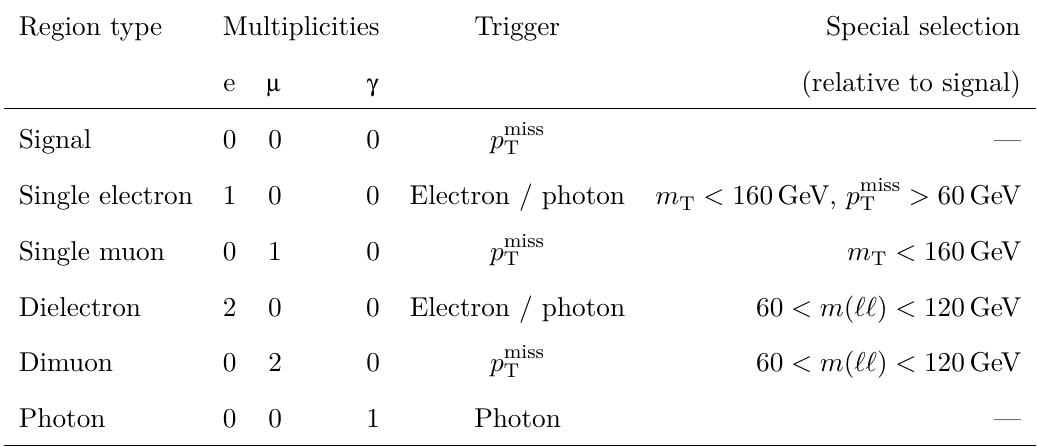
Table 2 . Summary of the topological selections used for different regions in the same category. Note that the trigger-level p miss calculation does not take into account muons, which makes the T p miss